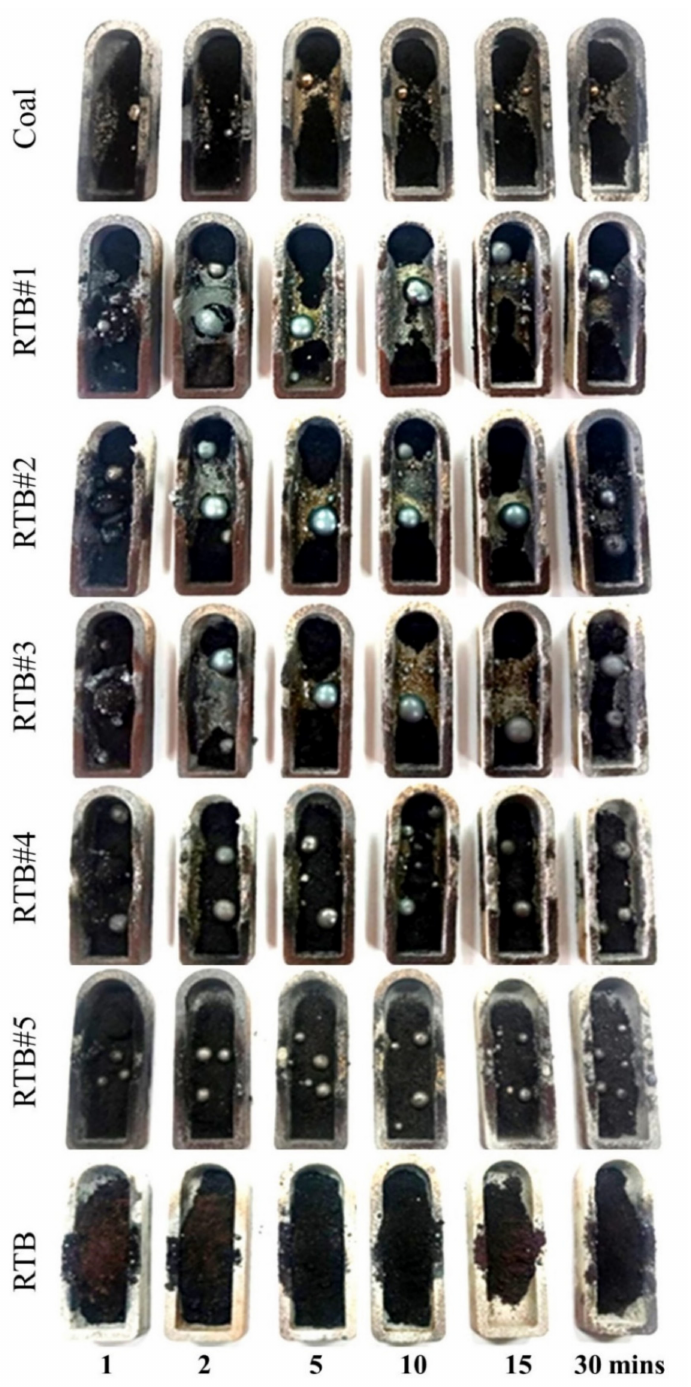
Figure 6. Carbon-mill scale composite pellet (CCP) after interaction at 1550 ◦ C for 30 min. The conversion of iron oxides into metallic Fe or Fe 3 C by removal of oxygen using a reductant can be measured in terms of metallization. In this study, the degree of metal- lization (DOM) is the extent of iron oxide reduction in the CCP. DOM is calculated as a percentage of the mass of metallic iron (Fe( Met ))divided by the mass of total iron (Fe( T )), Equation